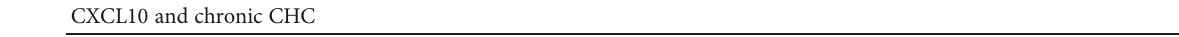
Table 2: CXCL10 and chronic